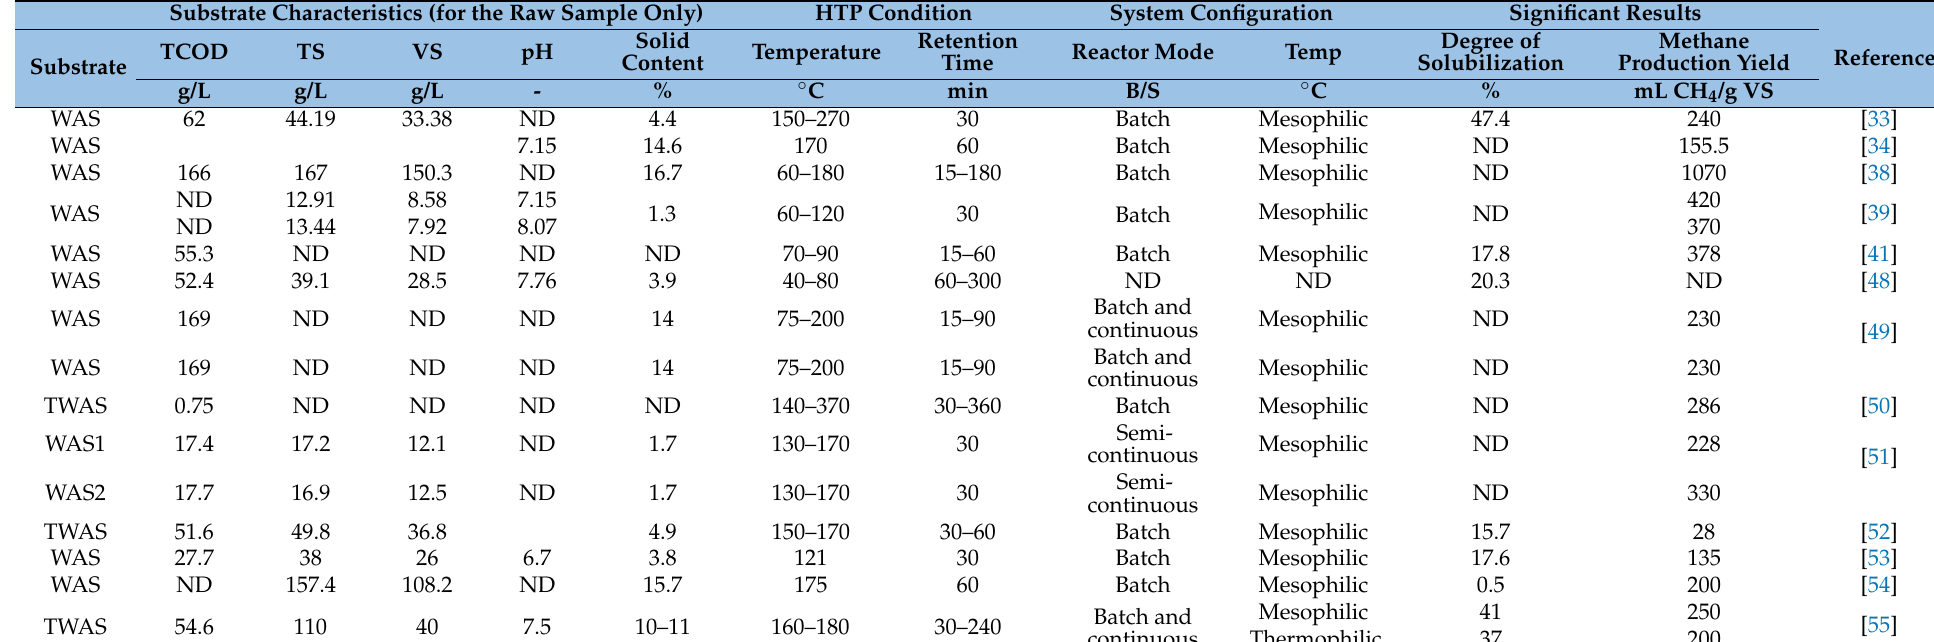
Table 2. Studies on hydrothermal pretreatment of TWAS for biomethane